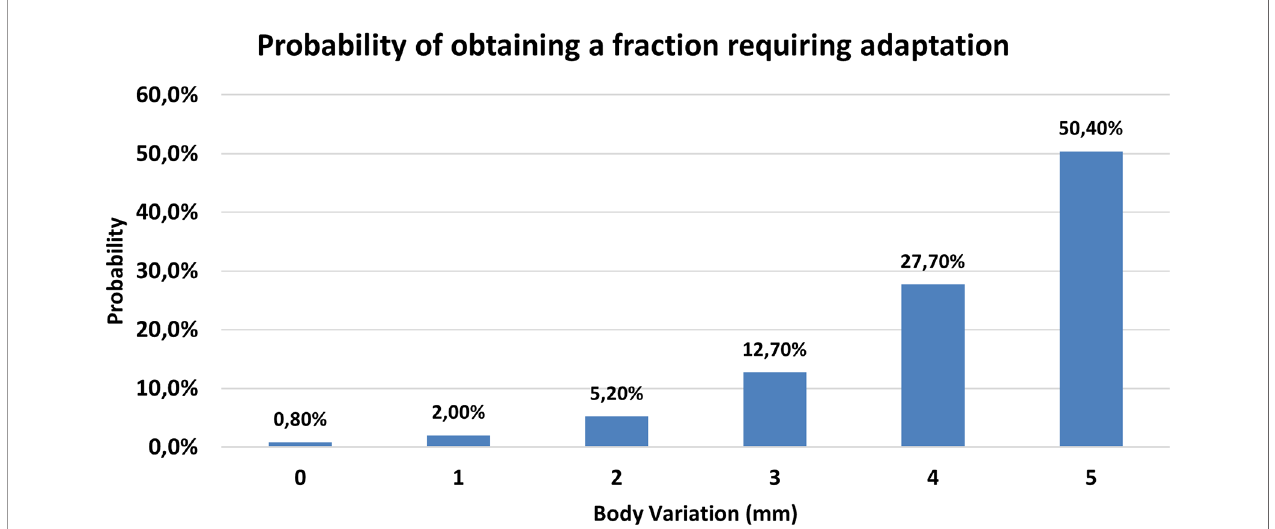
FIGURE 4 | Probability of obtaining a fraction requiring adaptation as a function of body variation measured along the beam axis with the highest